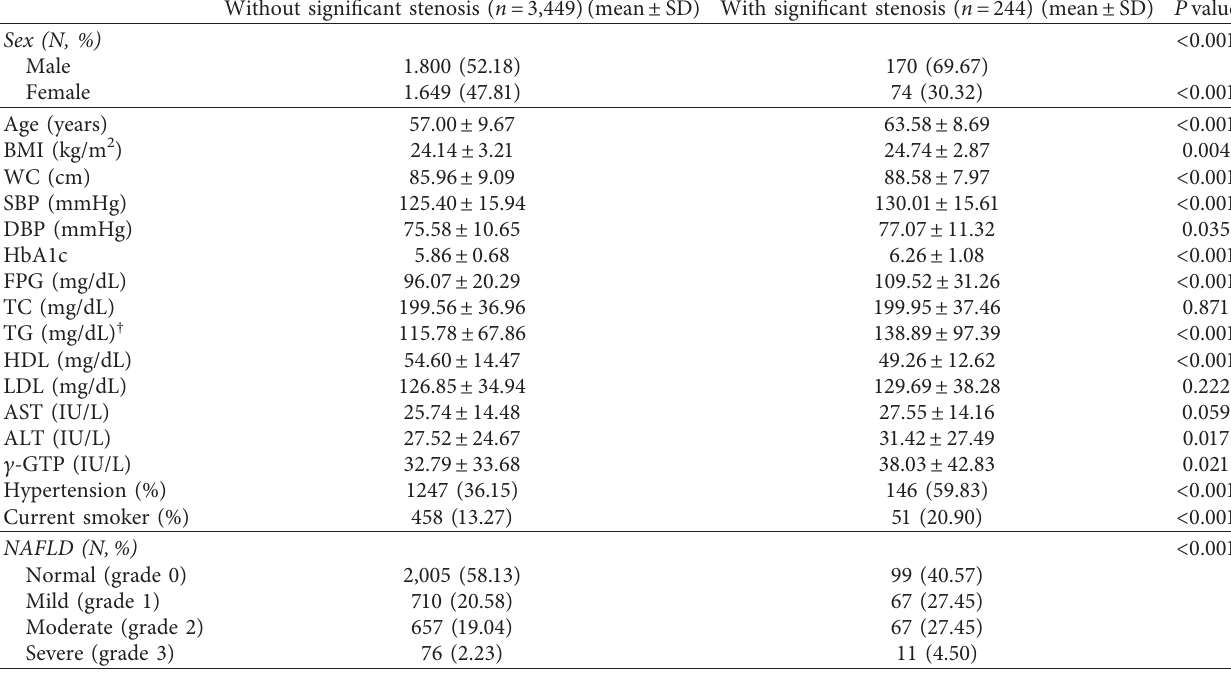
Table 1: General characteristics of the study population.